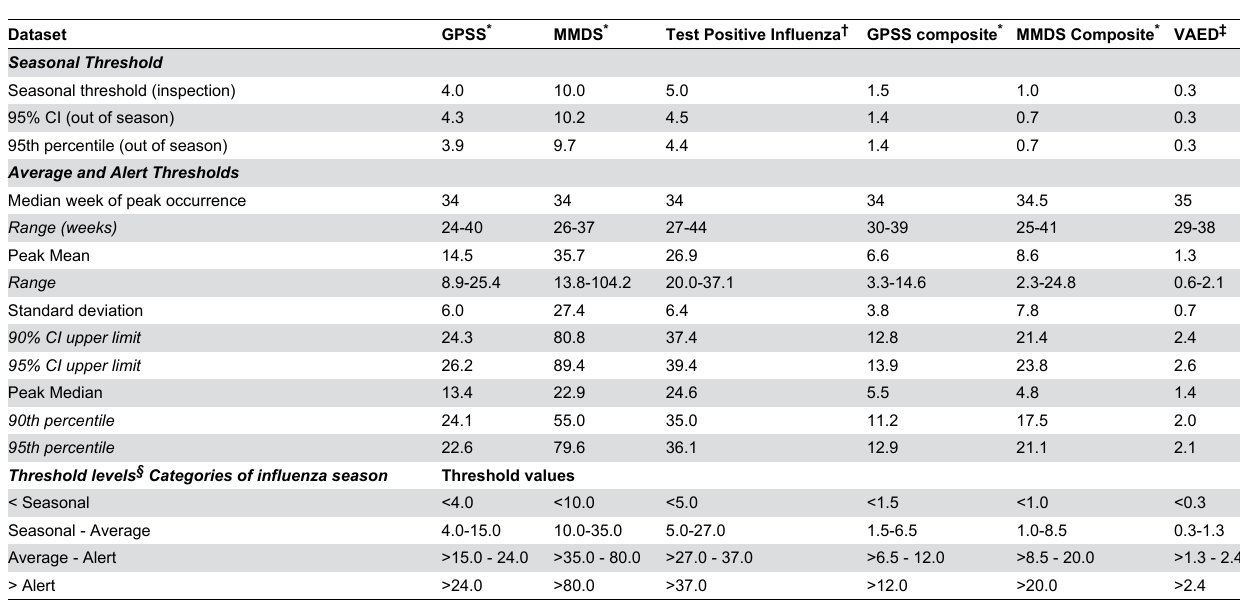
Table 1. Comparison of parametric and non-parametric parameters and thresholds for six surveillance datasets.